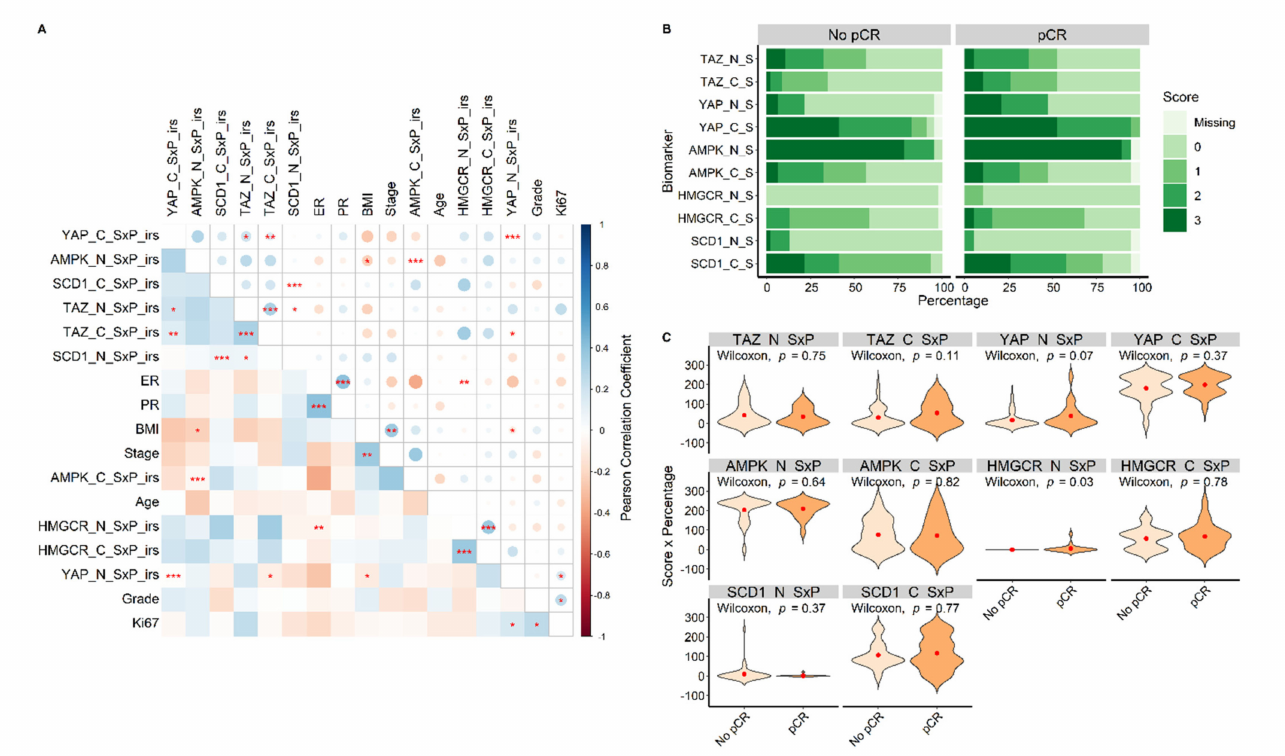
Figure 3. The correlation heatmap showing comparisons between all biomarkers and relevant clinical features is displayed in Panel ( A ). Blue color represents positive correlation coefficients, while red color represents negative correlation coefficients. The intensity of the color in the whole panel and the dimension of the circles in the upper triangle represent the magnitude of the correlation coefficients. Statistical significance levels are shown by asterisks as follows: * for p < 0.05, ** for p < 0.01, and *** for p < 0.001. The expression proportions of biomarkers in tumors that reached pCR compared to tumors that did not reach pCR (No pCR) are displayed in terms of percentage of cells stained (_P) in Panel ( B ) and in terms of immunoreaction intensity score (_S) in Panel ( C ). Suffixes: _N = nuclear; _C = cytoplasmic; _S = immunoreaction intensity score; _P = percentage of cells stained; _SxP = multiplication of immunoreaction intensity score with percentage of cells stained; SxP_irs = international immunoreactive